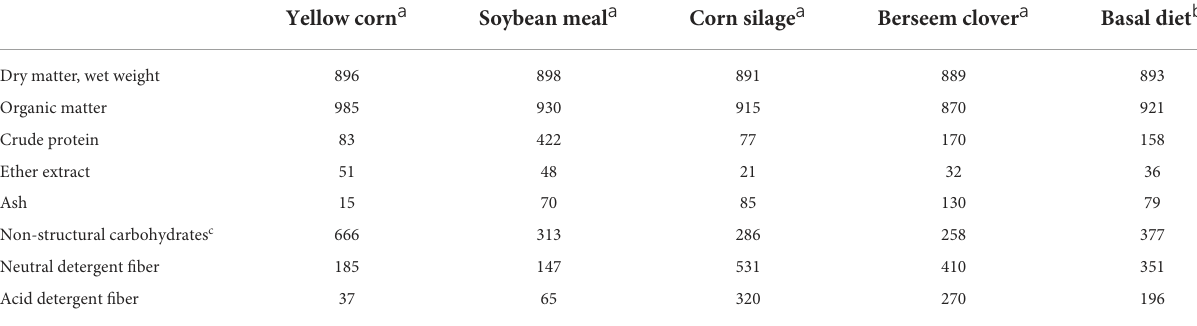
TABLE 1 Chemical composition of ingredients and control diet used in the in vitro and in vivo experiments (g/kg of dry matter). Yellow corn a Soybean meal a Corn silage a